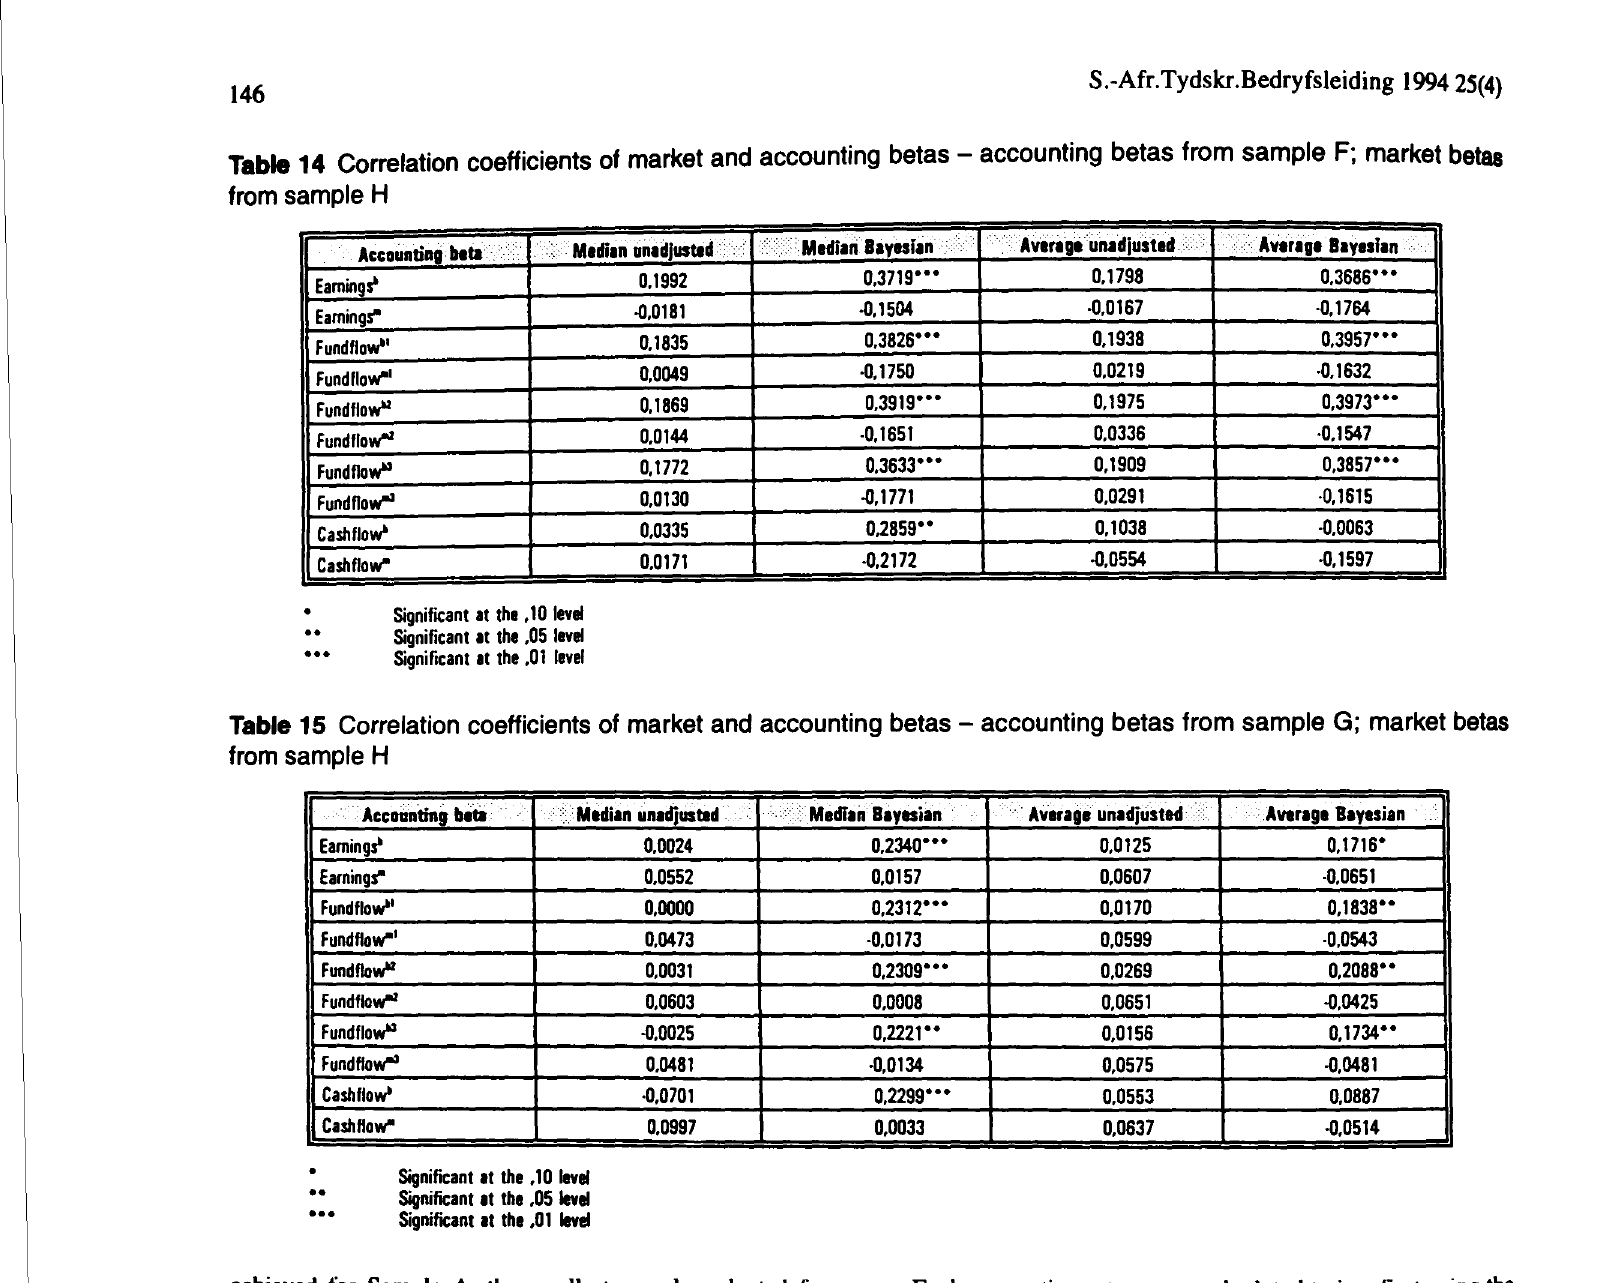
Table 15 Correlation coefficients of market and accounting betas - accounting betas from sample G; market betas from sample